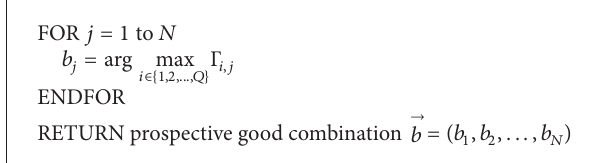
Algorithm 2: Calculation of mean value [Γ 𝑘,𝑗 ] 𝑄×𝑁 .